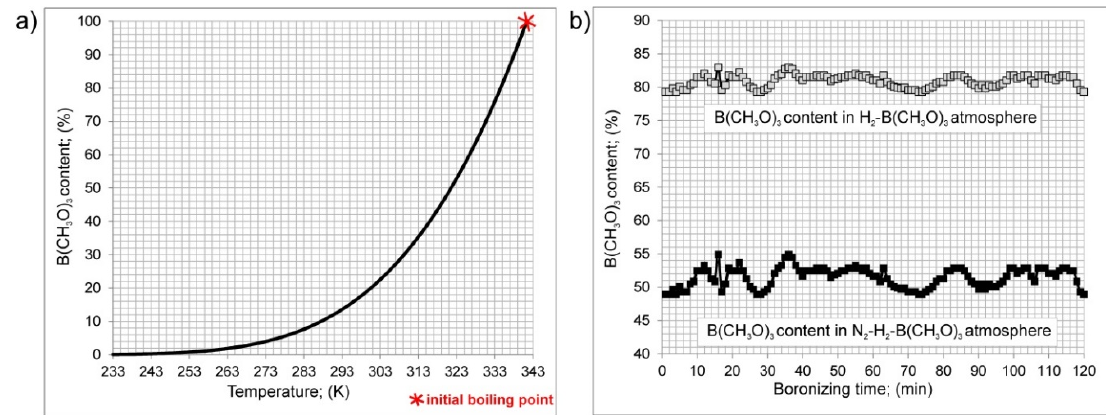
Figure 2. Scheme of trimethyl borate concentration: dependence of B(CH 3 O) 3 content on temperature ( a ); contents of trimethyl borate in relation to H 2 and in relation to the entire atmosphere during continuous gas borocarburizing in N 2 –H 2 –B(CH 3 O) 3 atmosphere ( b ).